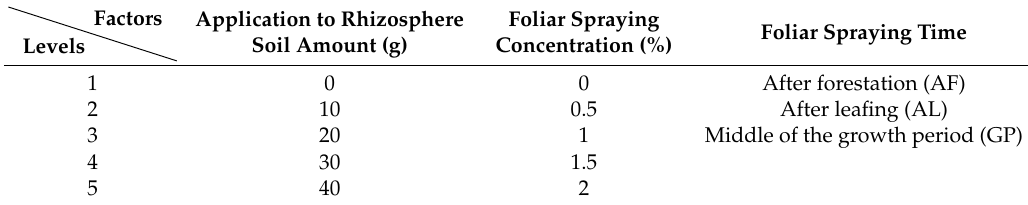
levels and 1 factor with 3 levels.